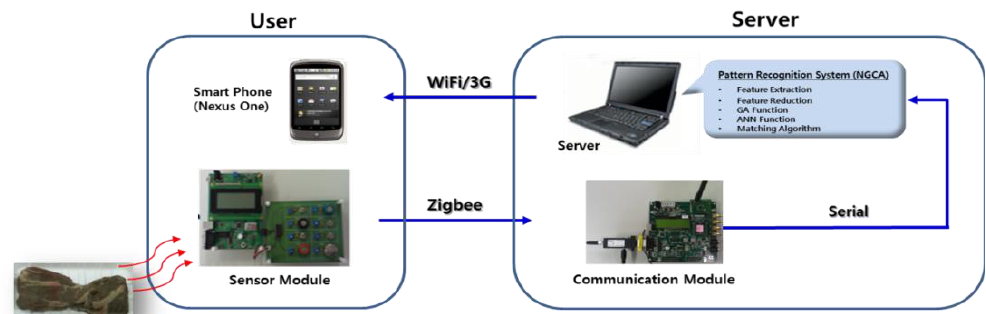
Figure 3. Detection system based on a gas sensor array and a